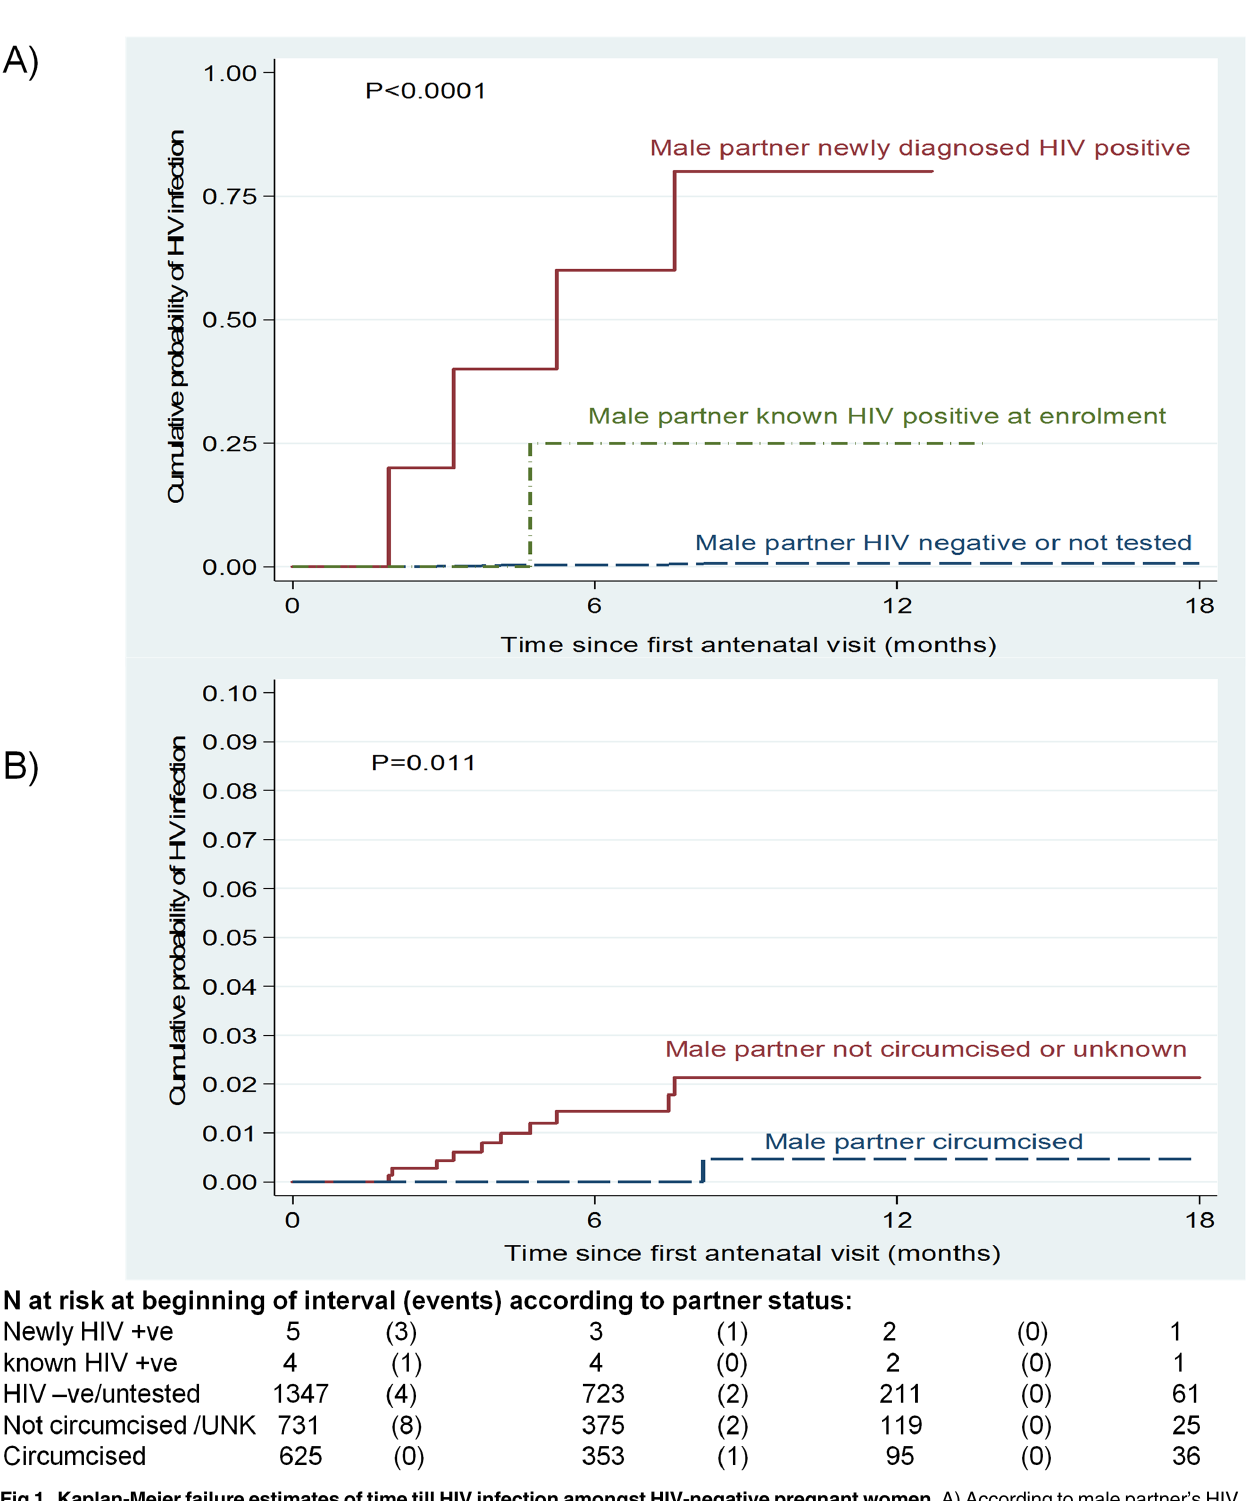
Fig 1. Kaplan-Meier failure estimatesof time till HIV infection amongst HIV-negative pregnant women. A) Accordingto male partner’s HIV serostatus, B) According to male partner’s circumcisionstatus.